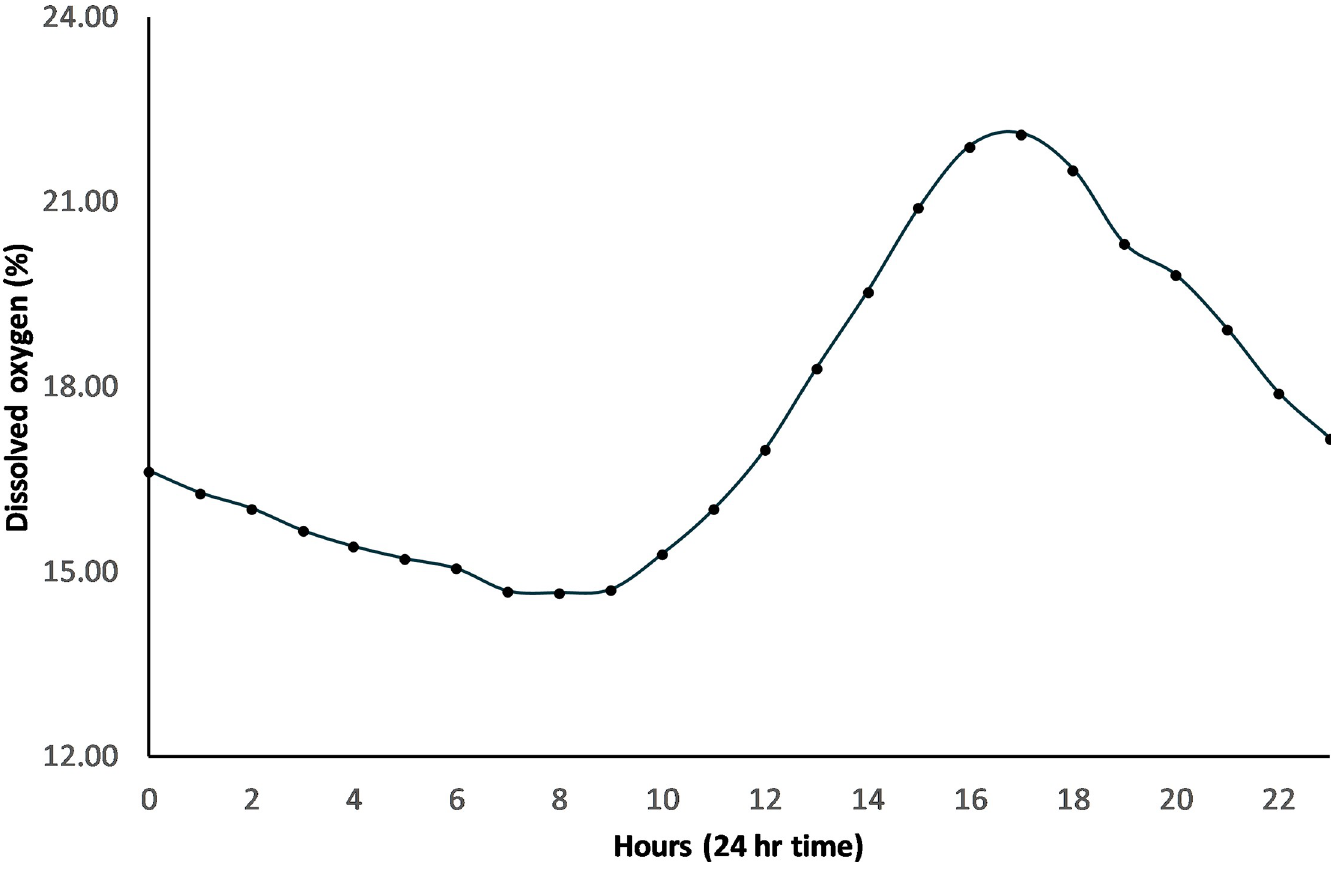
Fig 13. Mean hourly DO for the post bund period– 2014 to